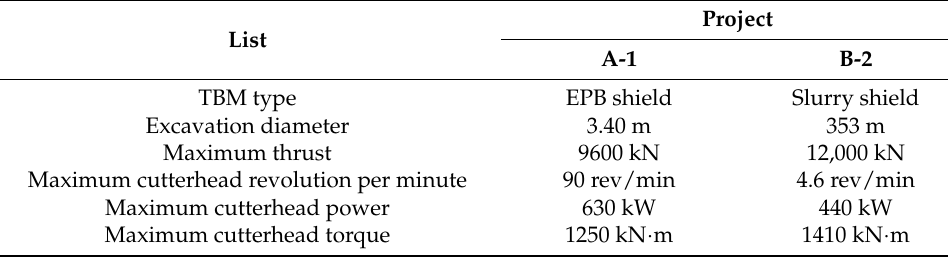
Table 1. Specifications of shield tunnel boring machine (TBM) applied to projects A-1 and B-2.